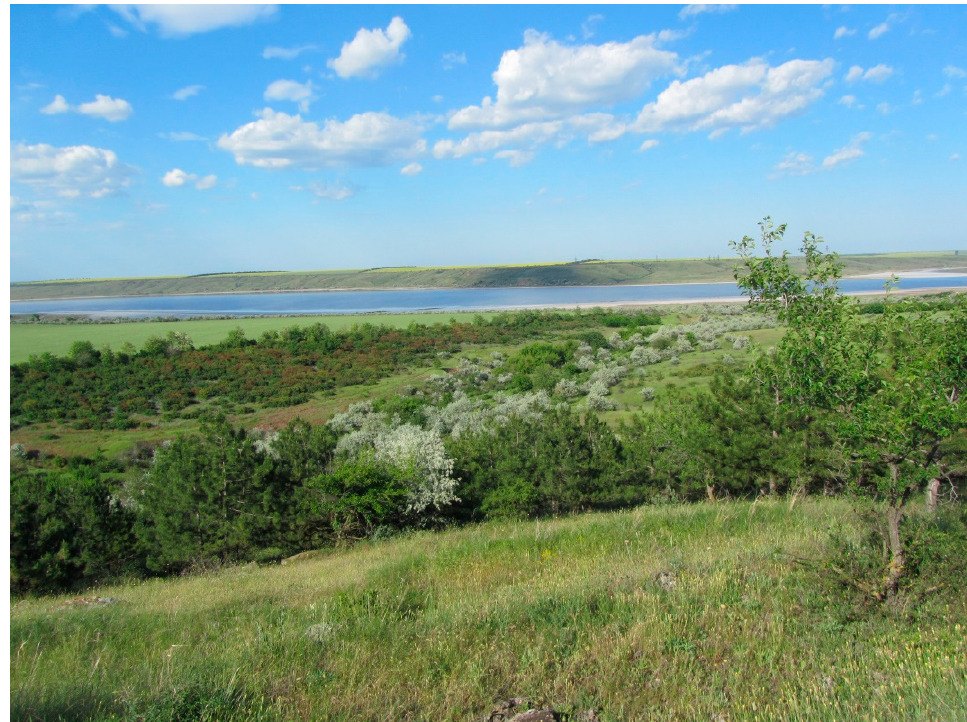
Figure 3. The right bank and the terraced slope of Kuyalnik Estuary (surroundings of Kovalivka village).